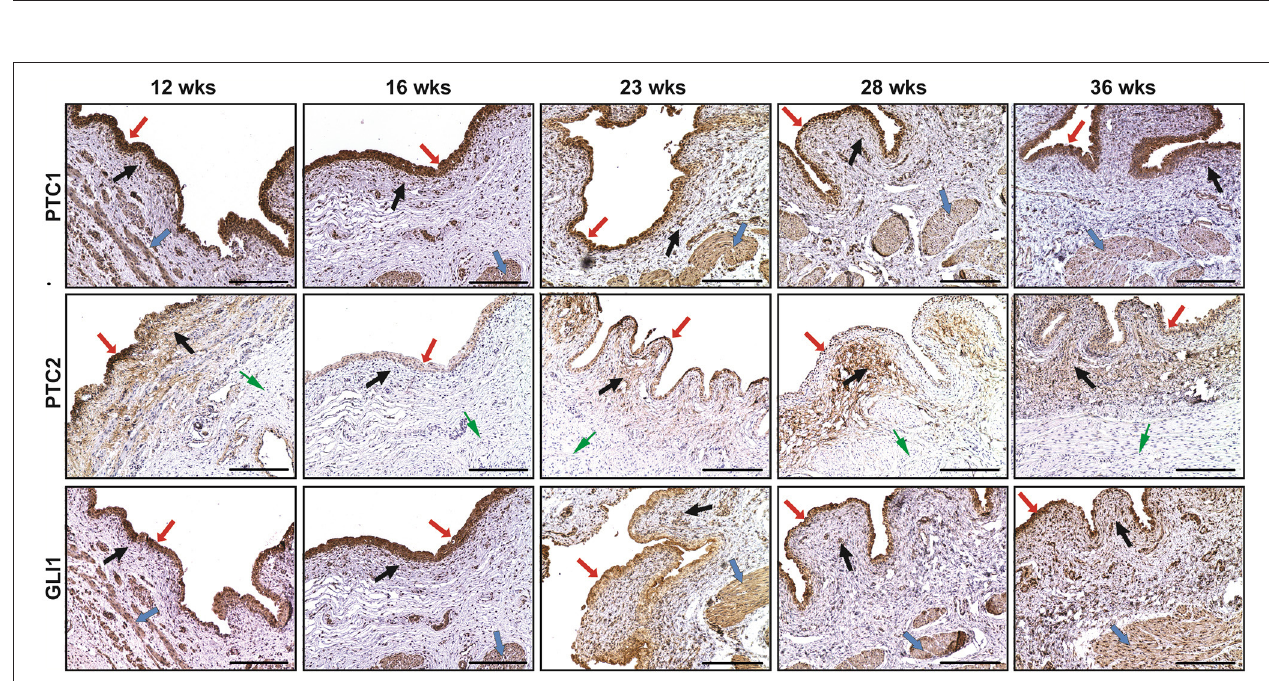
FIGURE 2 | The immunohistochemical staining of patched-1 (PTC1), patched-2 (PTC2), and GLI1 in human fetal bladders at different gestations. The spatial distribution patterns of PTC1 and GLI1 were characterized by minimal expression in the lamina propria ( BLACK arrows), moderate expression in the smooth muscle layer ( BLUE arrows), and high expression in the urothelium ( RED arrows). PTC2 expression was mainly localized in the urothelium ( RED arrows) and lamina propria ( BLACK arrows), but not in the smooth muscle layer ( GREEN arrows). Scale bars: 100 µ m.